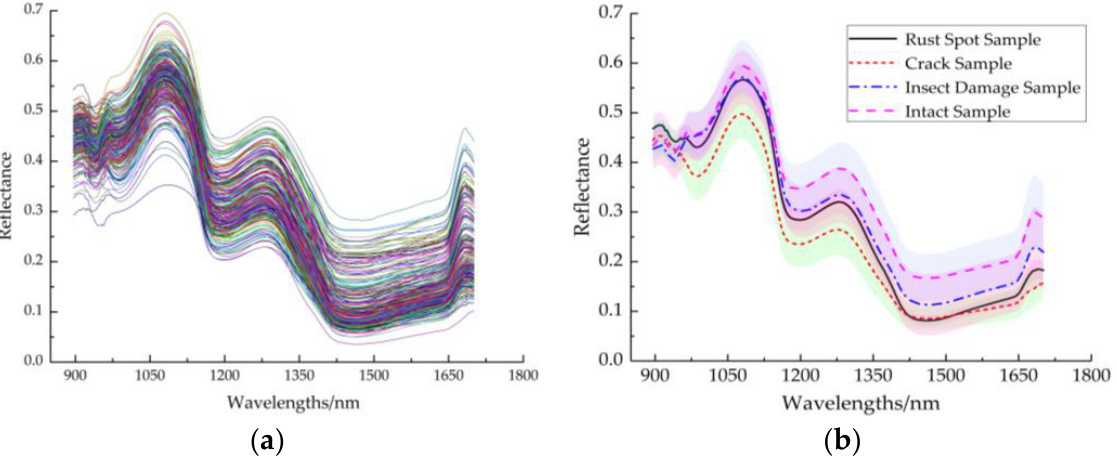
Figure 3. Spectral curves of four different Cerasus humilis fruit samples: ( a ) Original spectral curve; ( b ) Average raw spectra curve.